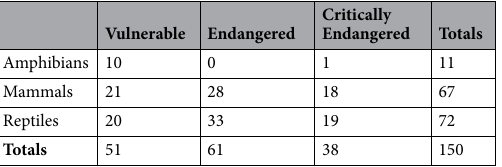
Species vulnerability data was obtained from the IUCN Red list 14 . This database has species names, their vul- nerability rankings and distribution detail. All threatened species (vulnerable, endangered and critically endan- gered) found in the study region and belonging to the taxonomic groups of amphibians, mammals and reptiles (terrestrial vertebrates) were downloaded and marine species excluded. Distribution data was downloaded in the form of polygon vector files. All data was re-projected to the same projection as the island database so that they could be overlain together and relevant information extracted for analysis. Finally, the extracted islands on which the species occurred, together with their indicative susceptibility val- ues, was overlain on regional scale sea level rise and projected mean significant wave height (Hs) information. This analysis was undertaken to identify those species that occurred on only a few islands with a high suscepti- bility category, were endemic to the Pacific and would be impacted by relatively higher sea level rise and mean significant wave height. What we are saying here is that, given two islands with exactly the same physical charac- teristics (same area, maximum elevation, shape and lithology), species on the one impacted by a higher sea level rise and mean significant wave height would be more vulnerable as that island becomes more susceptible under such conditions. For example, if both islands were small, low, narrow and sandy, the one in the projected higher sea level rise region would be more susceptible to change and thus species on that island would generally be more